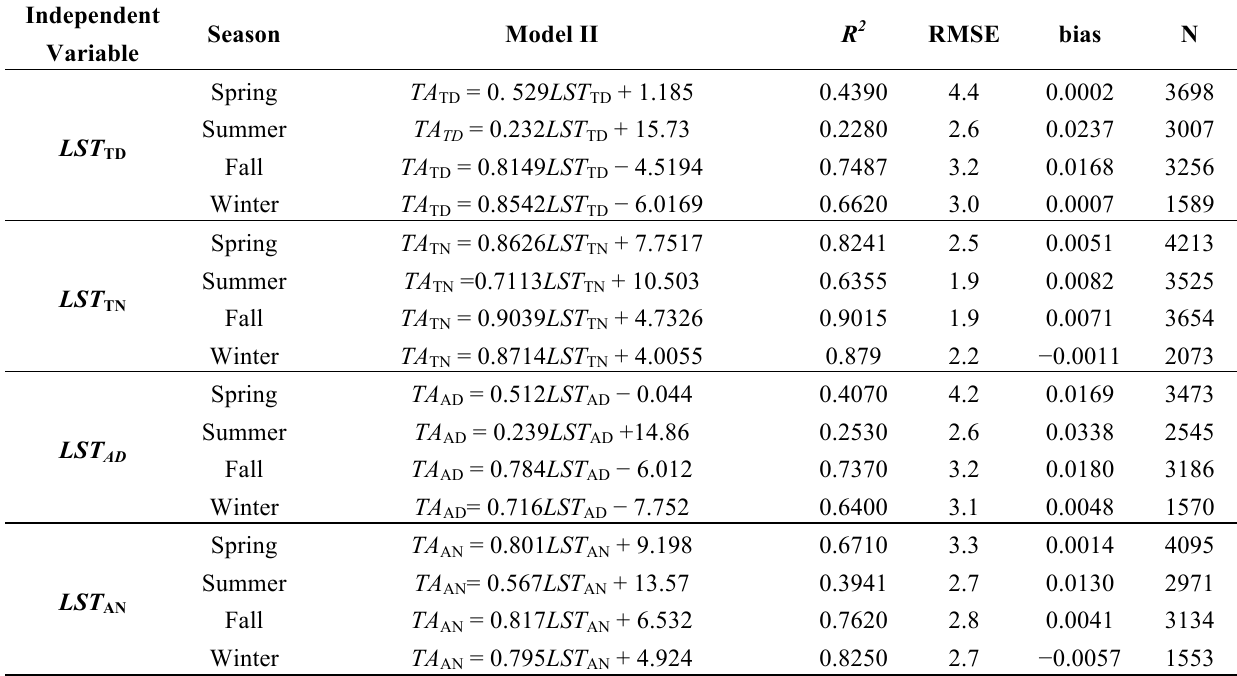
Table 2. Estimation models for daily mean air temperature ( TA ) in the spring, summer, fall, and winter using the MODIS-derived land surface temperatures (LSTs) as the independent